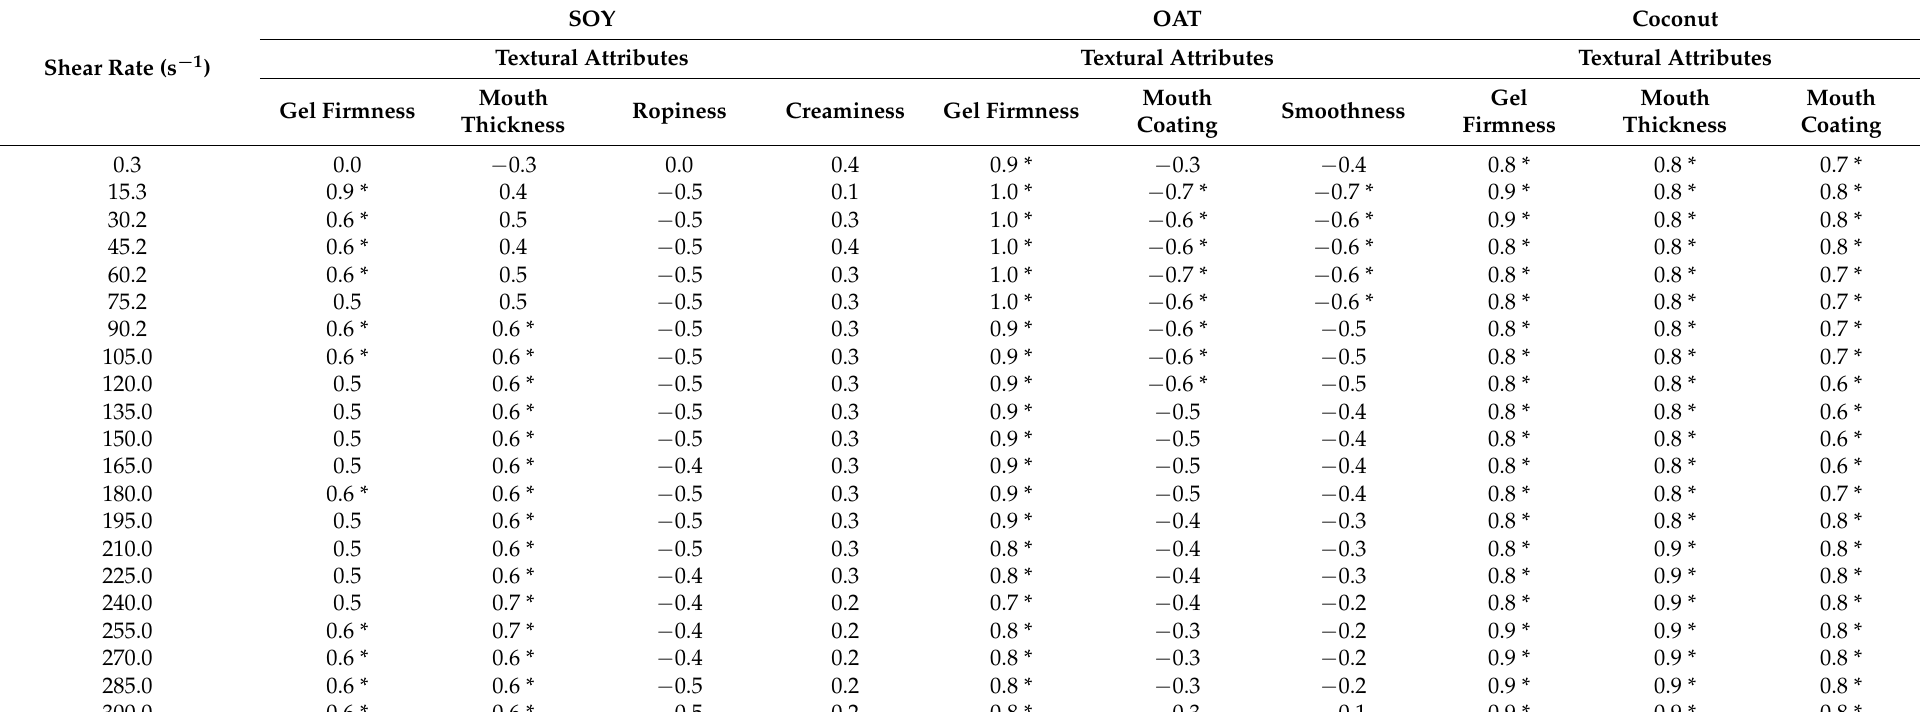
Table 6. Correlation coefficient between up-flow and textural attributes identified in each fermented